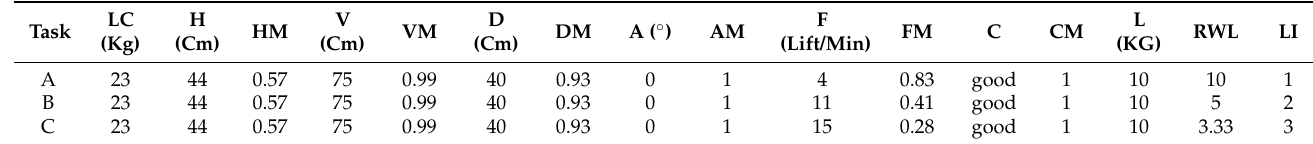
Table 1. For each task (A, B, and C), the values of the load constant (LC), the load weight (L), the horizontal (H) and vertical (V) locations, the vertical travel distance (D), the asymmetry angle (A), the lifting frequency (F) and the hand-to-object coupling (C) and the corresponding values of the multipliers (HM, VM, DM, AM, FM, CM), the recommended weight limit (RWL) and the lifting index (LI).